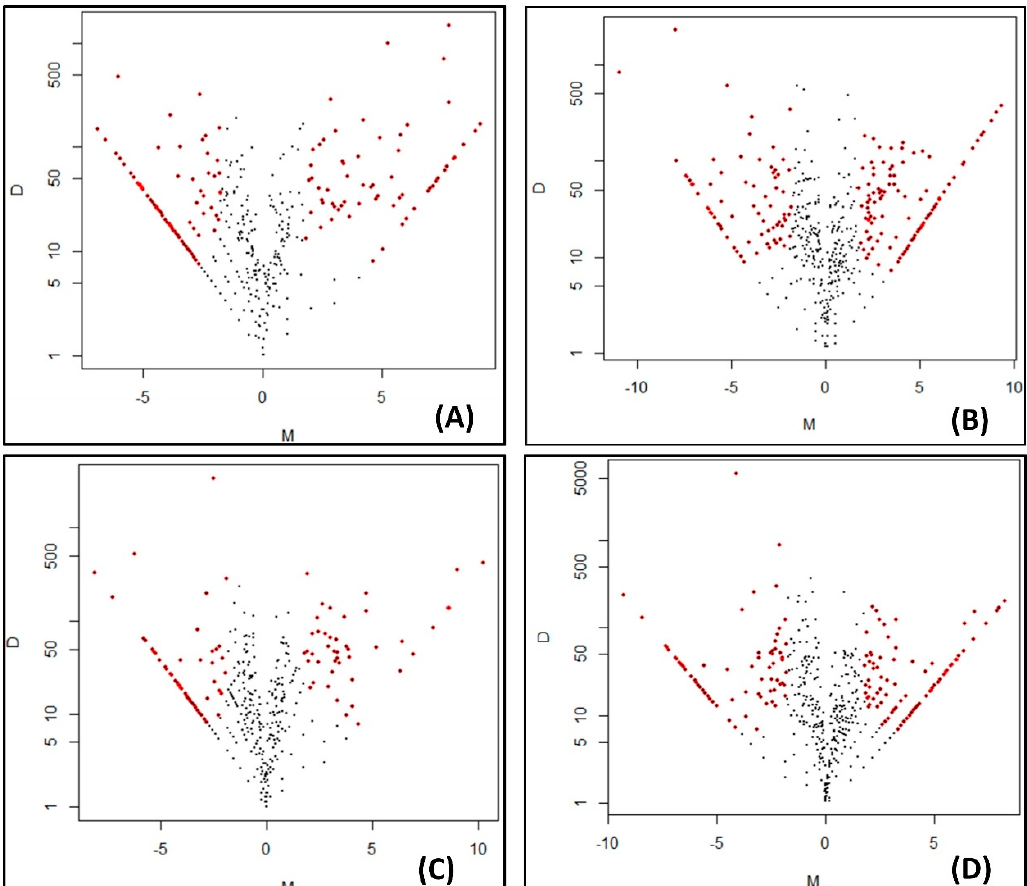
Figure 2. Volcano plots ( A ) LC:RC ( B ) LT:RT ( C ) LC:LT and ( D ) RC:RT.